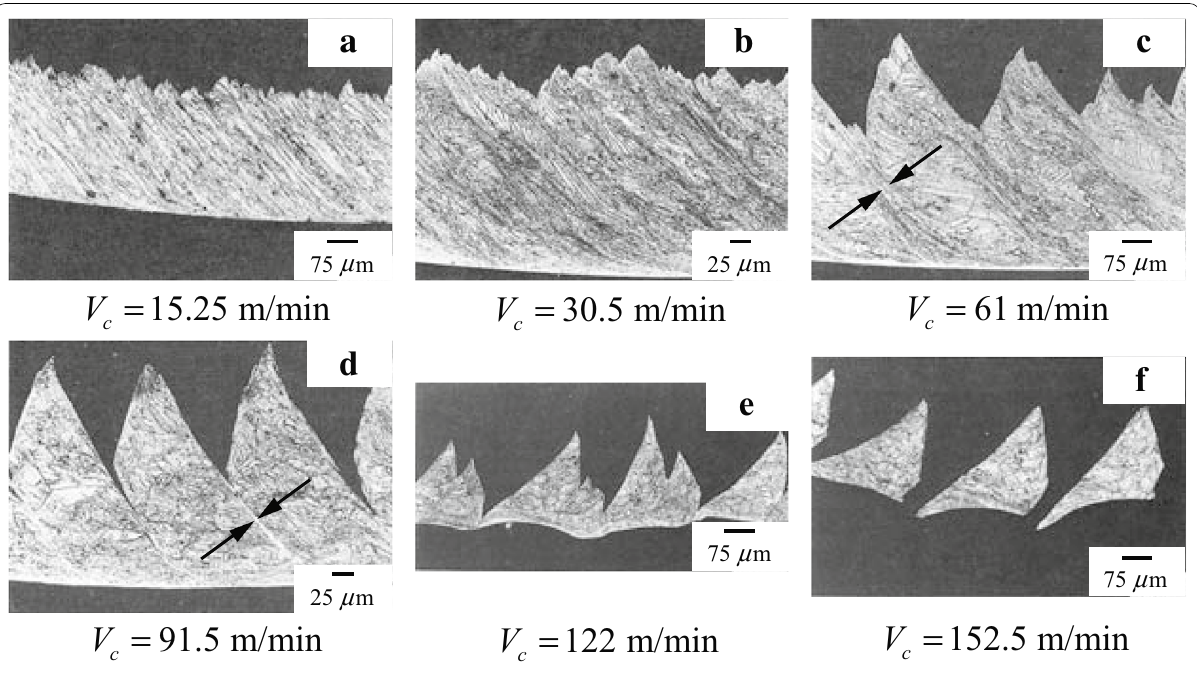
Figure 1 Chip patterns of Inconel 718 evolve with the cutting speed